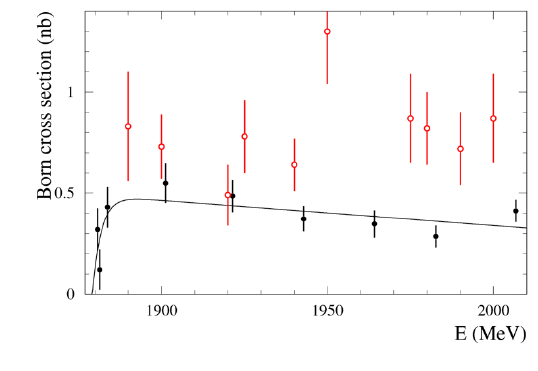
Figure 6: Preliminary results of the e + e − → n ¯ n production (black circles). Previous SND measurements [ 23 ] are shown by open circles.